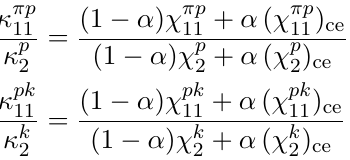
Figure 4 . Dependence of cumulant ratios (cid:20) pQ (cid:20) pk =(cid:20) k ( right panel ) on the acceptance (cid:11) , as calculated in the hadron resonance gas model 2 11